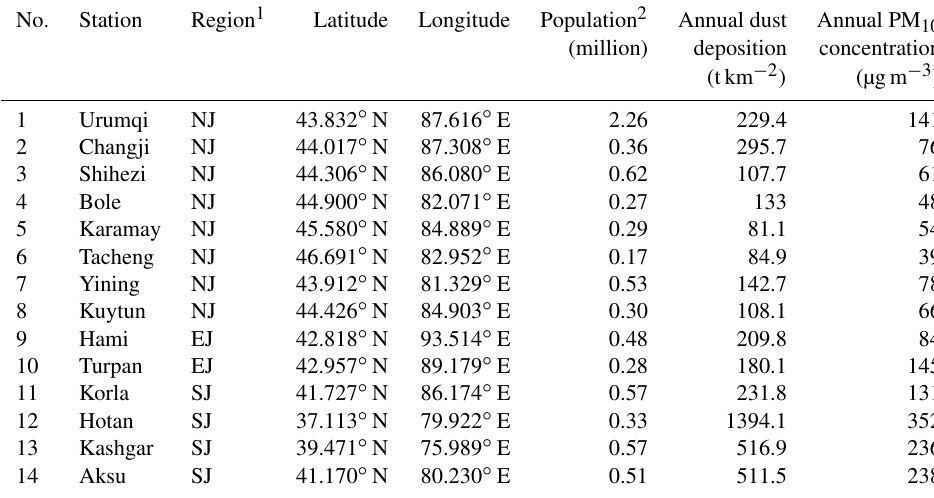
Table 2. Dust deposition and PM 10 concentrations at 14 stations in